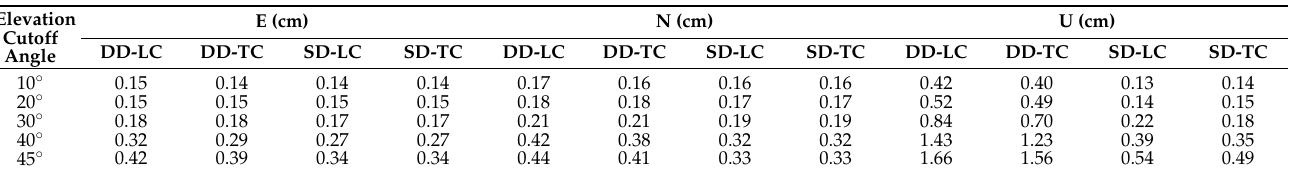
Table 9. The positioning RMS errors of the DD-LC, DD-TC, SD-LC, and SD-TC models under different elevation cutoff angles in the multi-epoch solution.